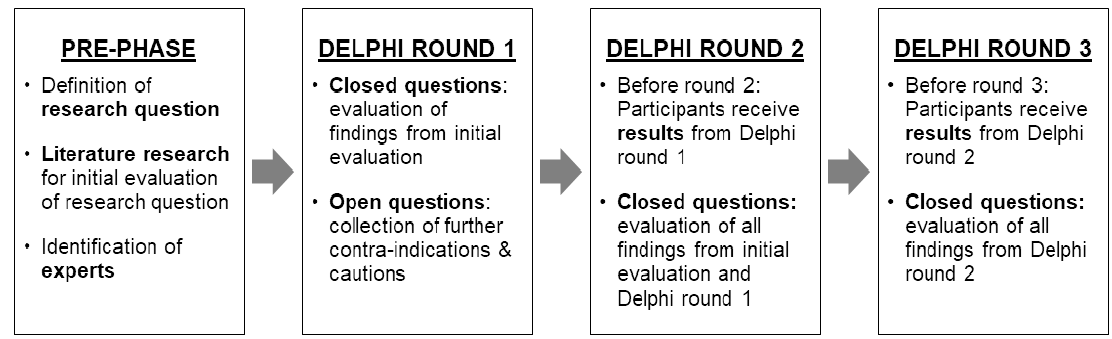
Figure 2. Overview of possible authors/academic experts and contact information.